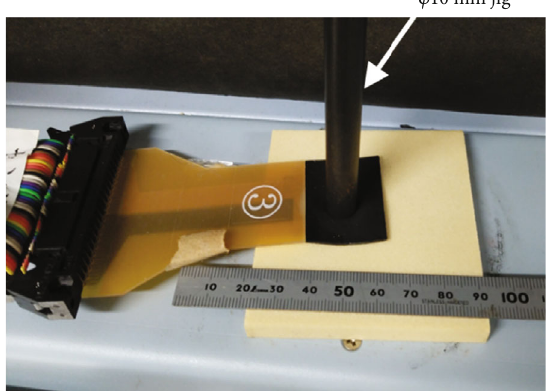
Figure 2: Reliability of the sensor. A compression test was performed using a φ 10 mm jig in the universal testing